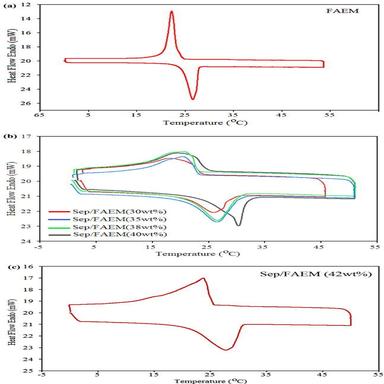
(a) DSC curve of the FAEM. (b) DSC curve of Sep/FAEM composites. (c) DSC curves of Sep/FAEM(42 wt%).